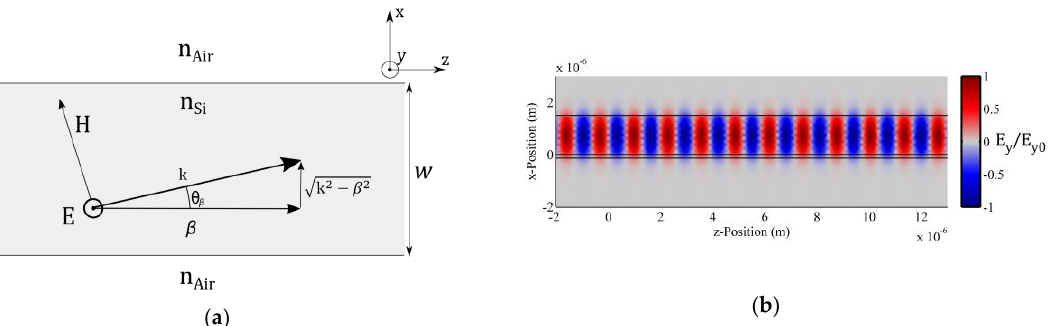
Figure A1. ( a ) Orientation of electric (E) and magnetic (H) fields for TE-polarization. ( b ) Normalized electric field component E y / E y 0 for a Si-slab waveguide with an additional Si 3 N 4 membrane with 140 nm thickness and w = 1.5 µm